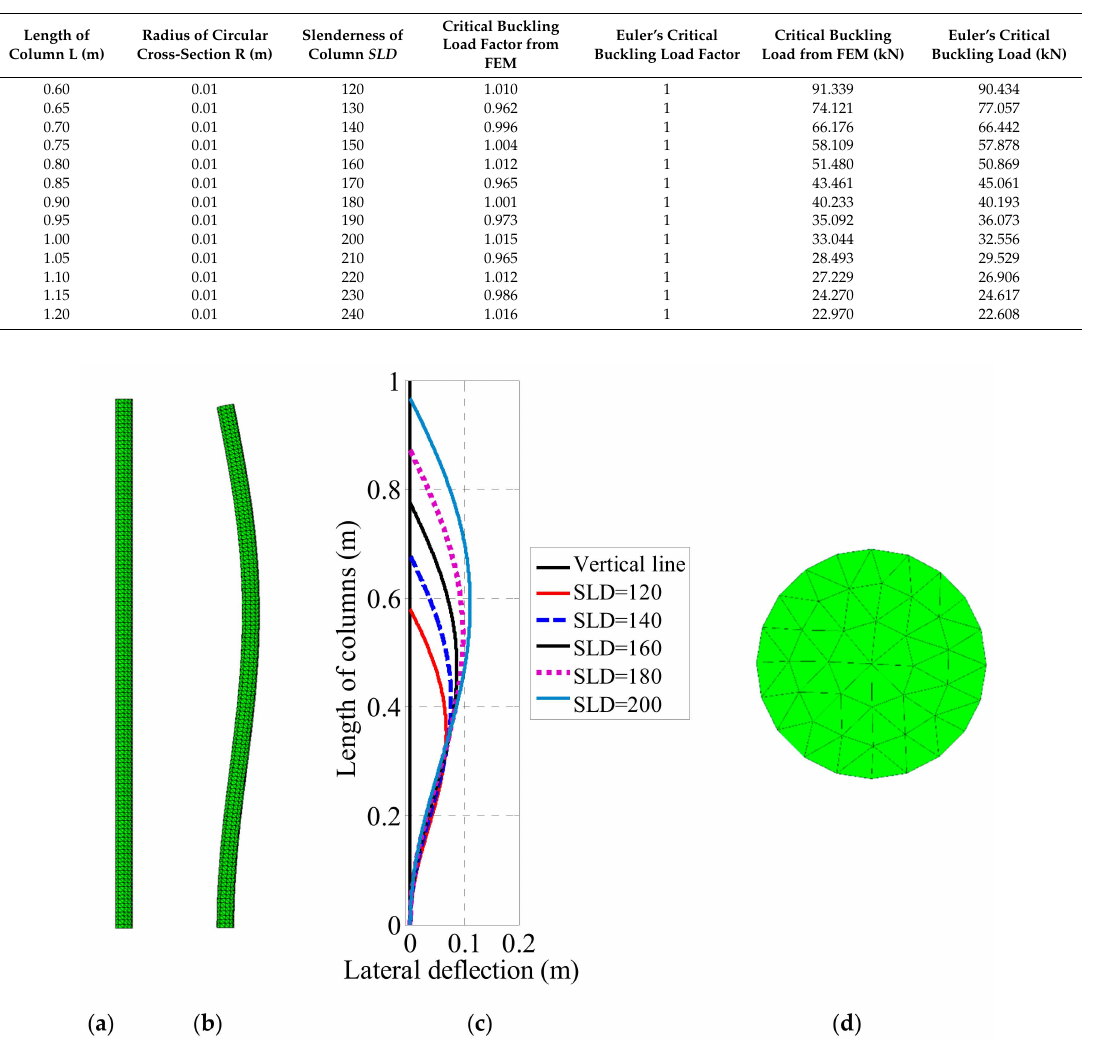
Table 1. Summarized information to validate the developed finite element tool.